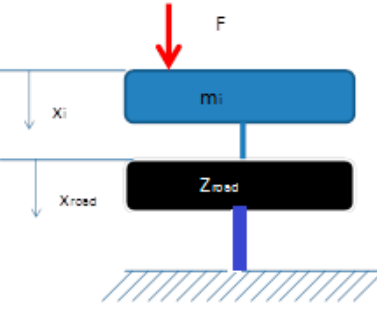
Figure 7. Mechanical impedance scheme.